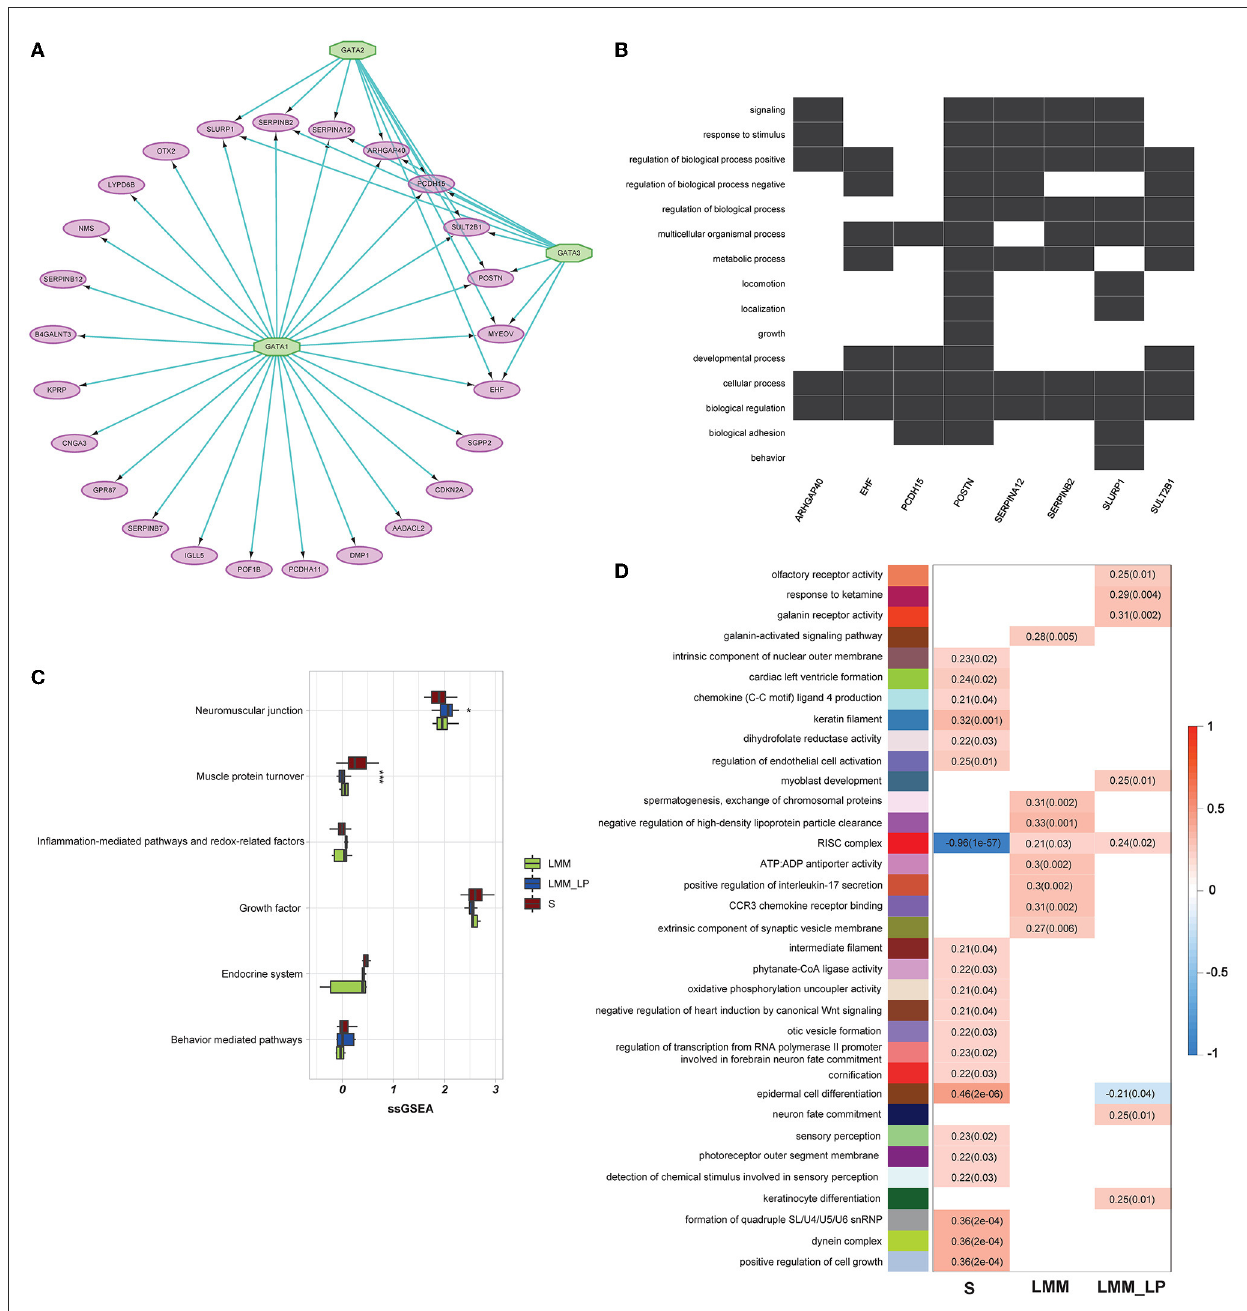
FIGURE3 Gene regulatory, weighted correlation networks, and pathophysiological mechanisms of different sarcopenia stages, low muscle mass, and low physical performance patients. (A) Gene regulatory network of the top upregulated genes under sarcopenia using iRegulon software. Results show GATA1, 2, and 3 as top regulators and their relationship with the nine predicted direct targets. (B) Heatmap-like functional classification depicts the linkages of predicted genes and biological concepts (e.g., GO terms or KEGG pathways). (C) Comparison of the pathophysiological mechanisms between the S, LMM, and LMM_LP groups (ANOVA test, p -values are shown. * p < 0.5, ** p < 0.01, and *** p < 0.00). (D) Significant gene modules and their representative gene ontology differentially enriched between sarcopenia (S), low muscle mass (LMM), and low muscle mass with physical performance (LMM_LP), which were identified by WGCNA. The P -values are shown in parentheses.